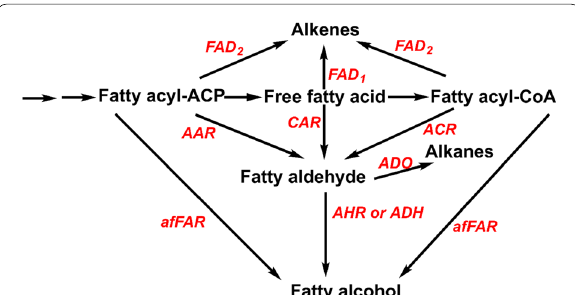
Fig. 5 Schematic diagram of the synthetic pathway of fatty alcohols and aliphatic hydrocarbons production by microorganisms. Two arrows represent multiple